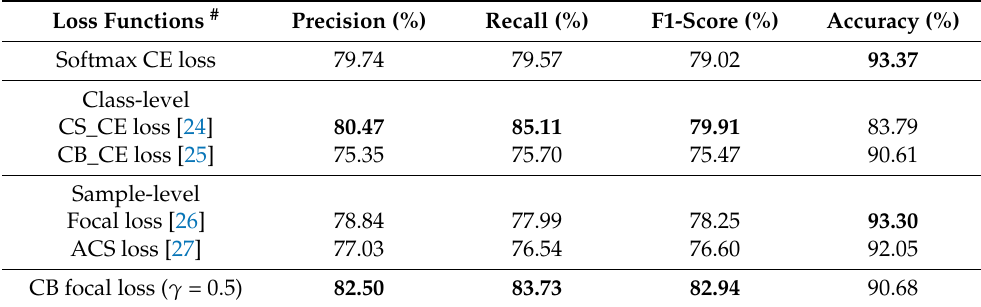
Table 4. Classification performance comparison with different loss functions. The best two results for each metric are highlighted in bold.